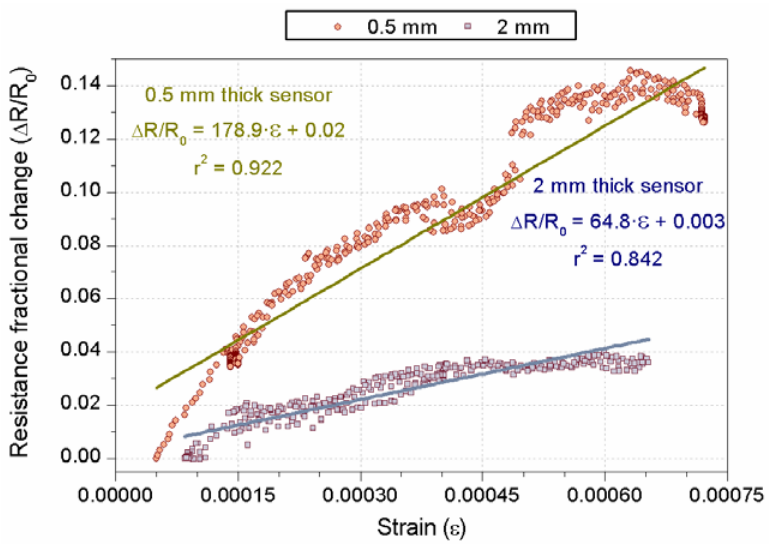
Figure 9. Comparison of 1% CF10 sensors with different thicknesses (0.5 mm and 2